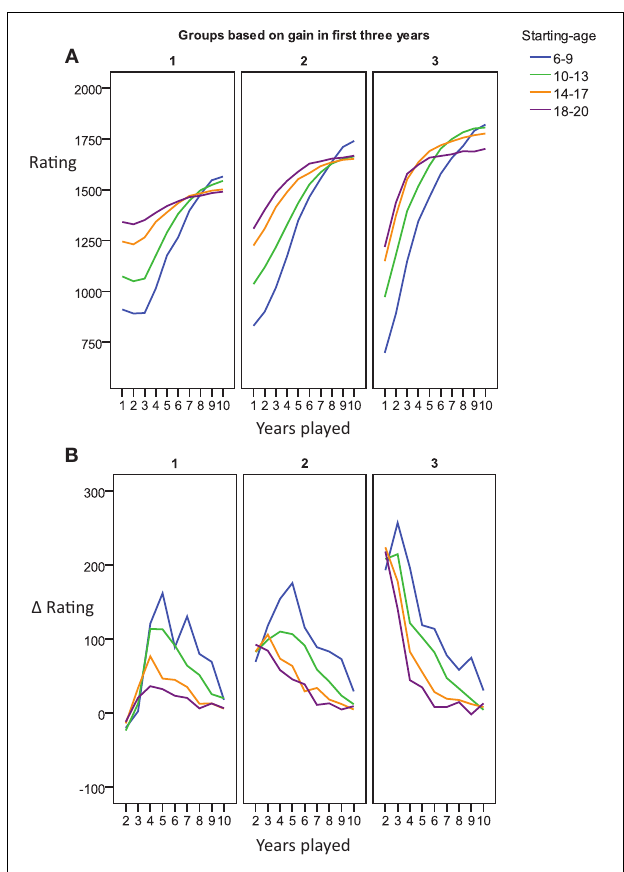
FIGURE 5 | (A) Charts the average time course in tournament performance for players starting at 6–20 years of age grouped by improvement over the first three years. (B) Shows the change in ELO per year.